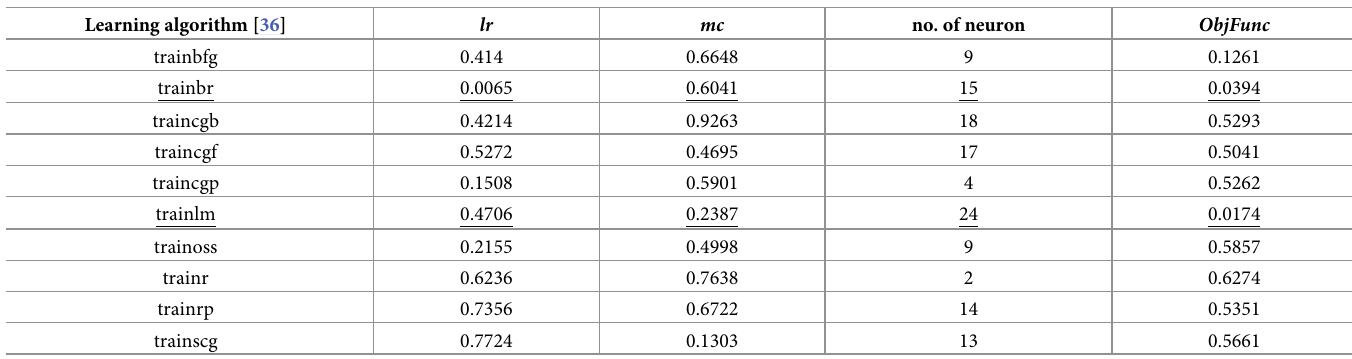
Table 1. ObjFunc based on different type of learning algorithm.